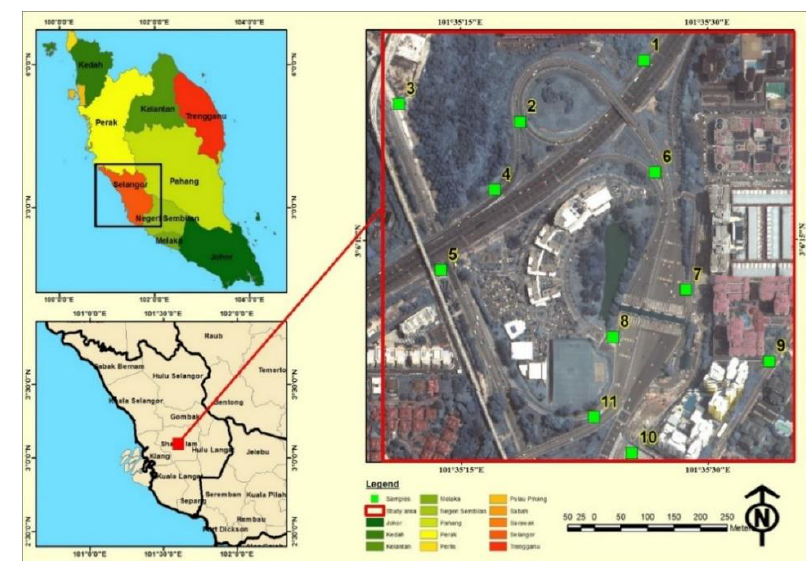
Figure 3. The sampling locations.